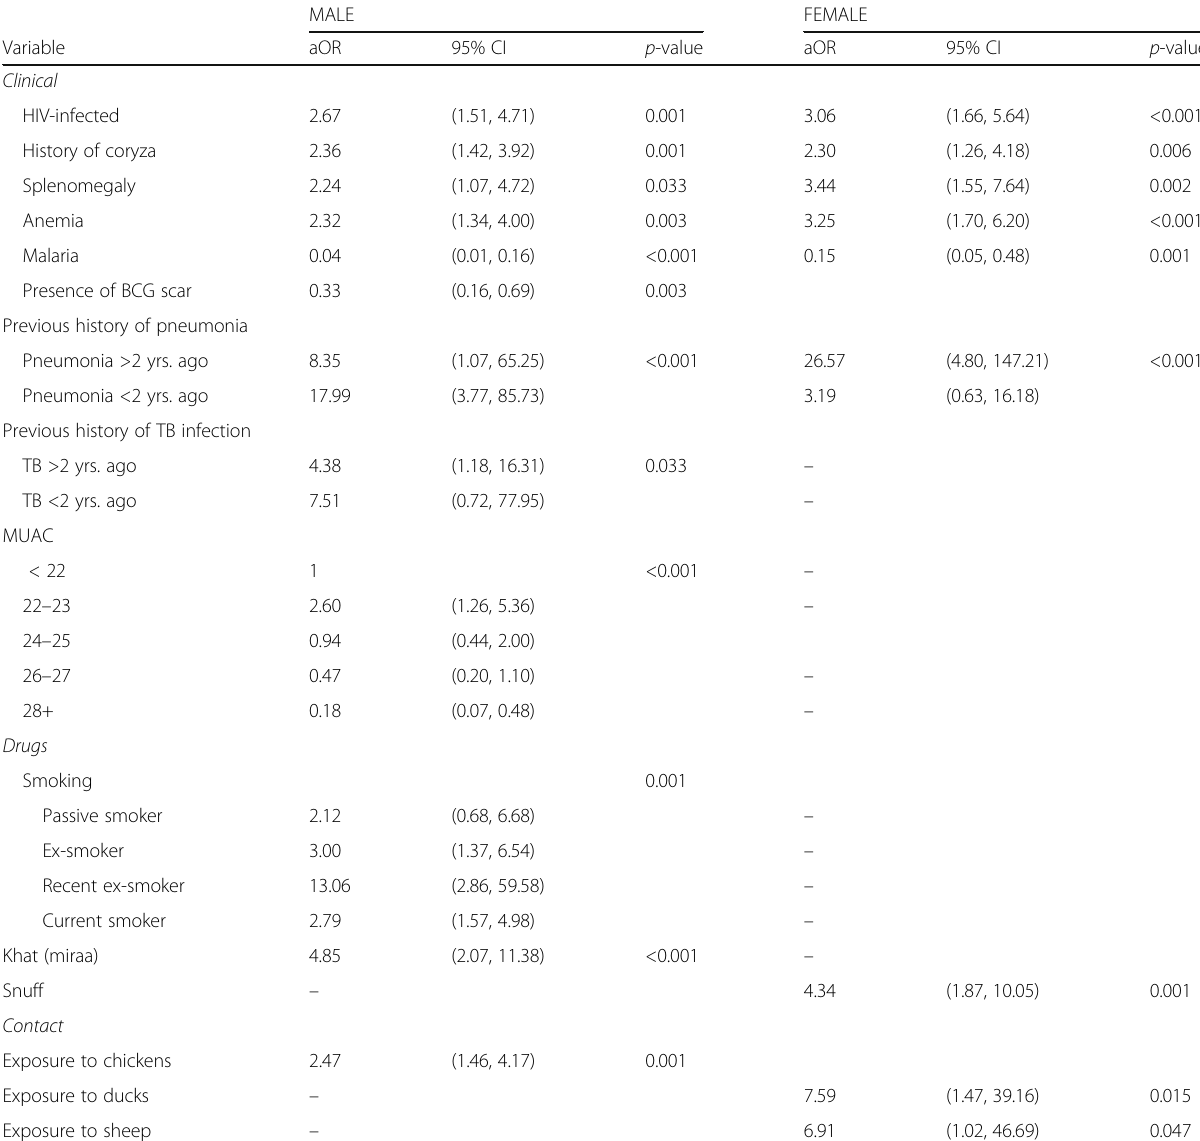
Table 4 Risk factors for pneumonia by sex